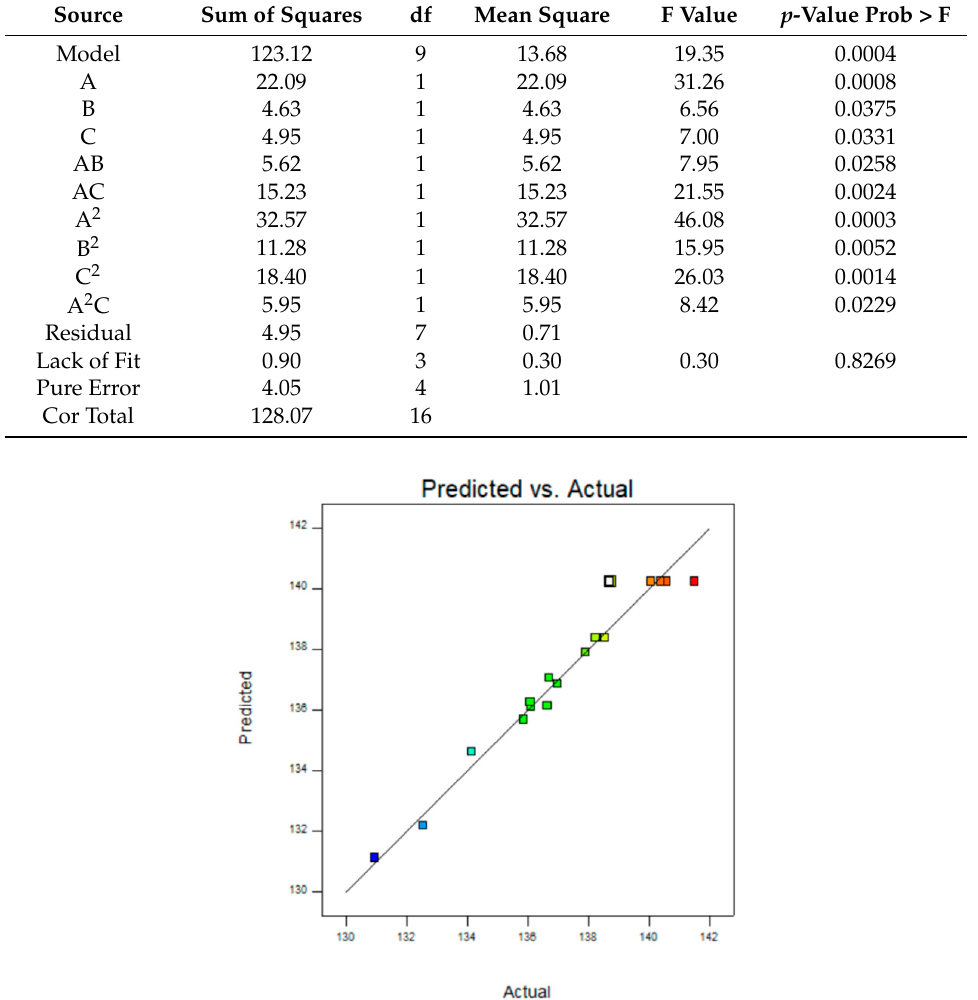
Table 3. Analysis of experimental variance results.